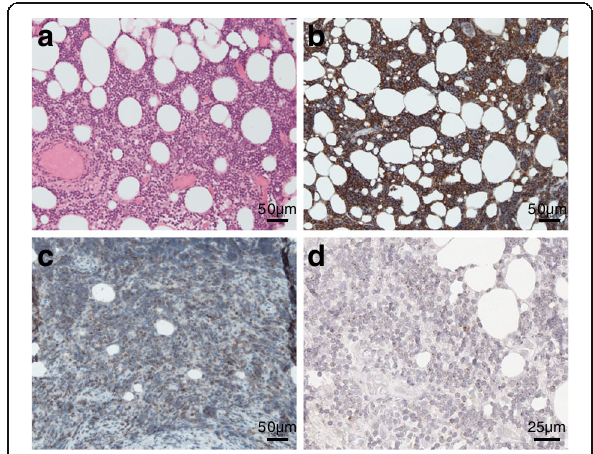
Fig. 1 Histology and immunohistochemistry (IHC) for CD20, Bcl-2 and CXCR4 expression in lymphoma biopsy . a H&E staining. b IHC for CD20. c IHC for Bcl-2. d IHC for